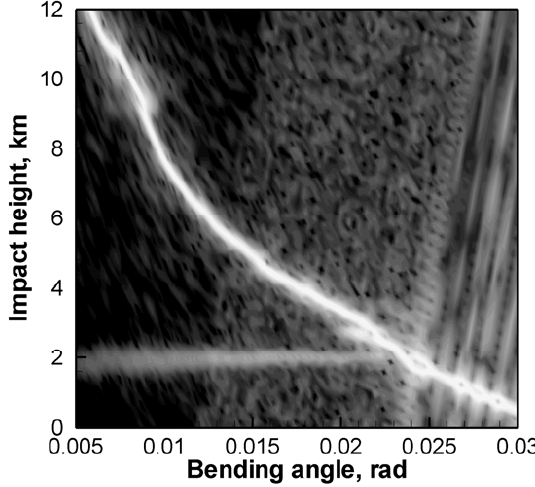
Fig. 1. Occultation event observed on 30 September 2007, UTC 01:22, 56.72S 3.53E. Reflection and multipath over Atlantic Ocean. Figure 1. Occultation event observed on September 30, 2007, UTC 01:22, 56.72S 3.53E. 3 Reflection and multipath over Atlantic Ocean. 4